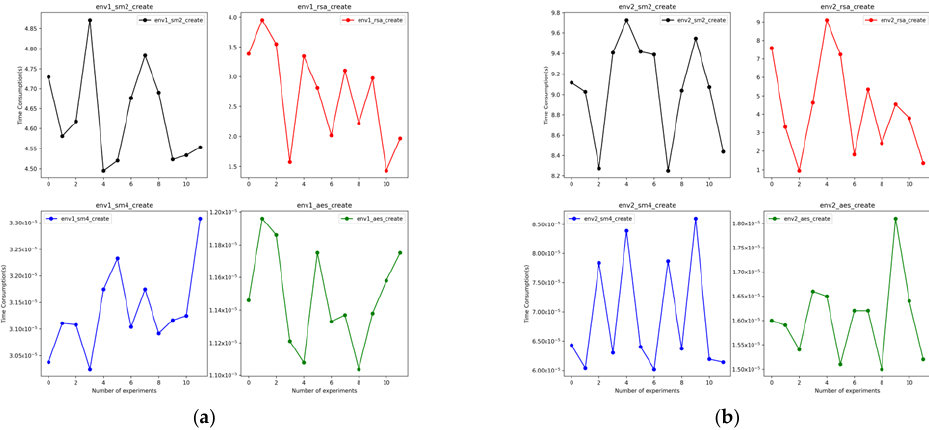
Figure 9. Time consumption for generating key pairs using SM2, SM4, AES, and RSA algorithms in env-1 ( a ) and env-2 ( b ).